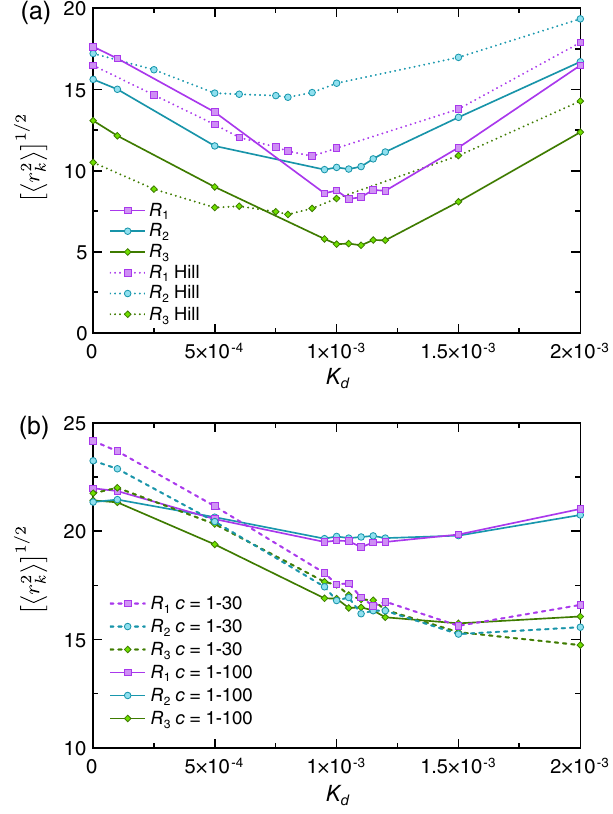
FIG. 6. rms residual, Eq. (C4), as a function of the equilibrium dissociation rate K . (a) Solid lines: results from the common fit d of the experimental datasets c ¼ 1 – 10 for the three repeats R 1 – 3 . Dotted lines: results for the Hill model with fragmentation; see Eq. (E2) and Appendix E. (b) Results from the common fit of the experimental datasets for c ¼ 1 – 30 (dashed lines) and c ¼ 1 – 100 (solid lines) for the three repeats R 1 – 3